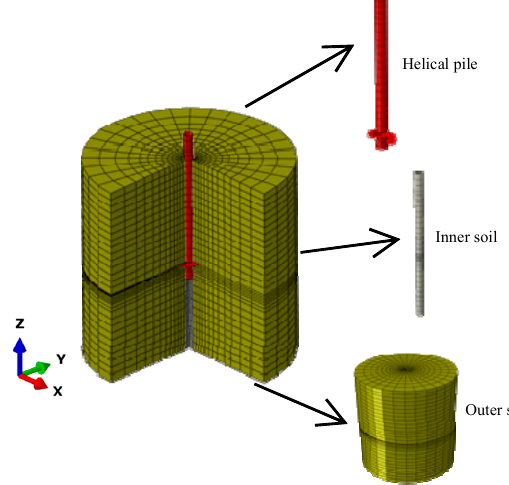
Figure 1. Mesh division for single helical pile model.